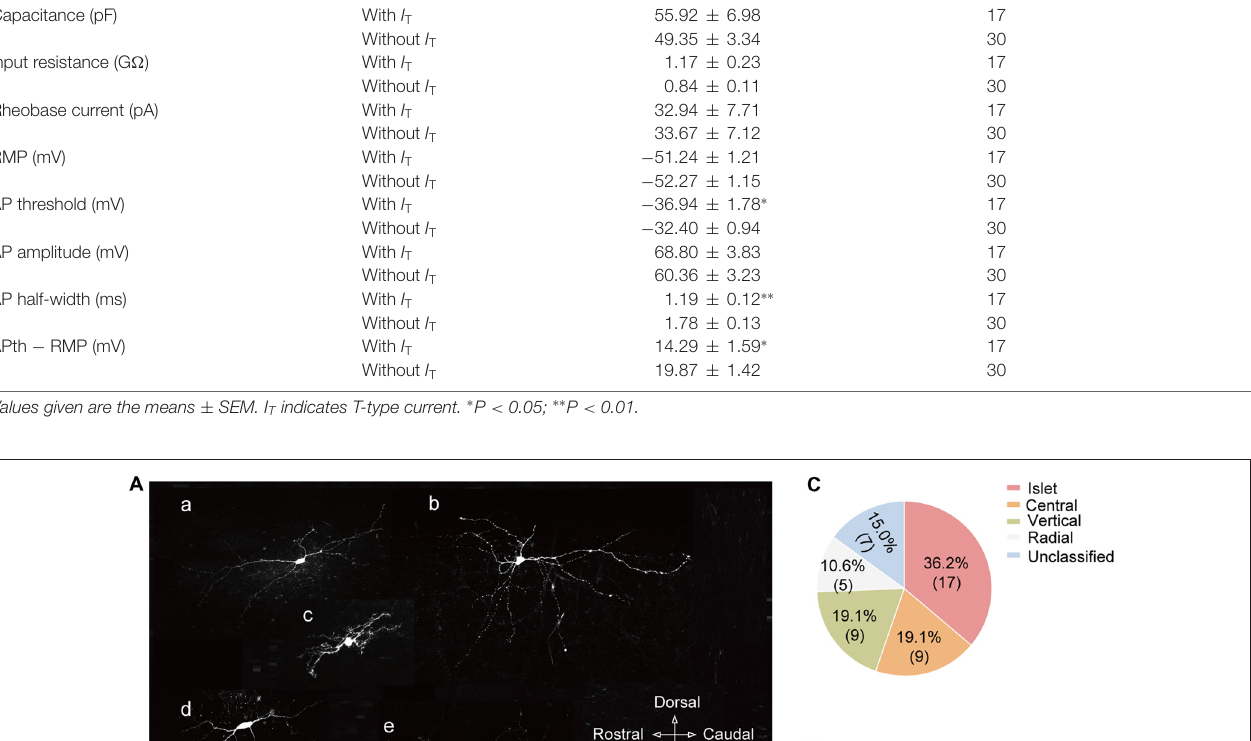
TABLE 1 | Membrane properties of T-type current-expressing or -lacking neurons. Parameter Group Total Number of cells Capacitance (pF)